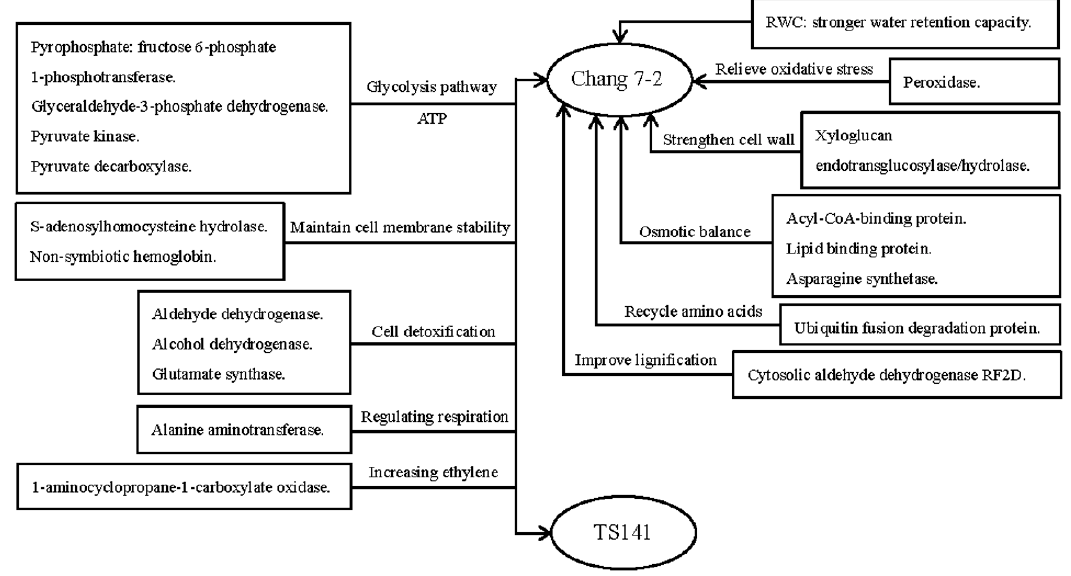
Figure 8. Molecular model of the response of Chang 7-2 to drought